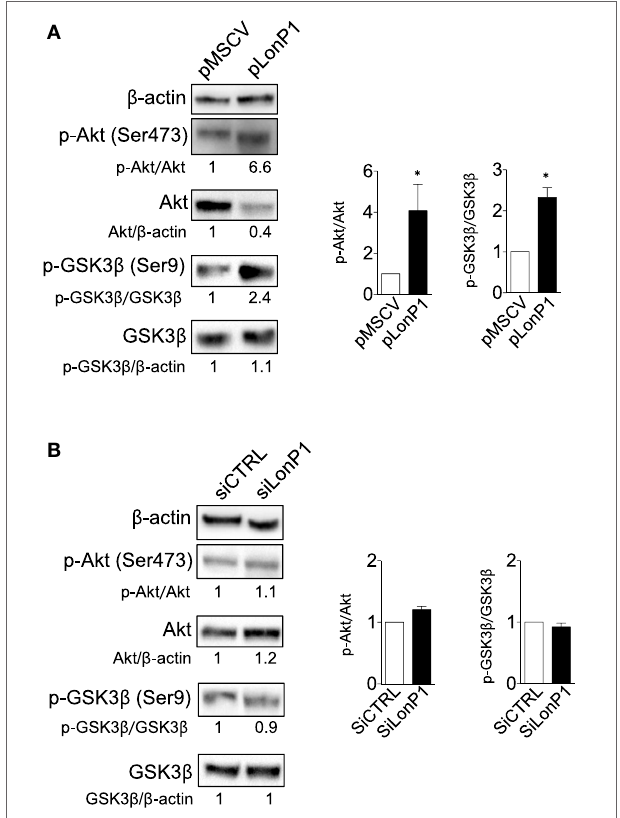
FigUre 5 | LonP1 modulates β -ctn by regulating Akt/GSK3 β signaling. (a) Representative Western blot analysis and relative protein levels of phosphorylated Akt (Ser473), Akt, phosphorylated GSK-3 β (Ser9), and GSK-3 β in SW480 cells overexpressing LonP1. (B) Representative Western blot analysis and relative protein levels of phosphorylated Akt (Ser473), Akt, phosphorylated GSK-3 β (Ser9), and GSK-3 β in SW620 downregulating LonP1. β -actin was used as loading control. Densitometries are reported in histograms, and data are reported as mean ± SD ( n = 3). * P <